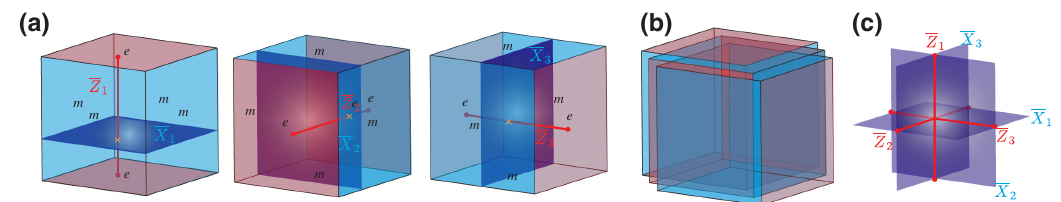
FIG. 23. The arrangement of a stack of three 3D surface codes for the application of a transversal logical CCZ gate. (a) The pairs of e -boundaries are chosen to be perpendicular to the z , x , and y directions, respectively. (b) The three copies are stacked together such that the corresponding qubits acted on by the transversal CCZ gate in each copy are aligned with each other. (c) The alignment of the three pairs of logical operators. All logical Z -strings are perpendicular to each other and the same is true for the logical X -branes. copy of 3D color code, which can be classified as a 3D Z × Z × Z topological 2 2 2